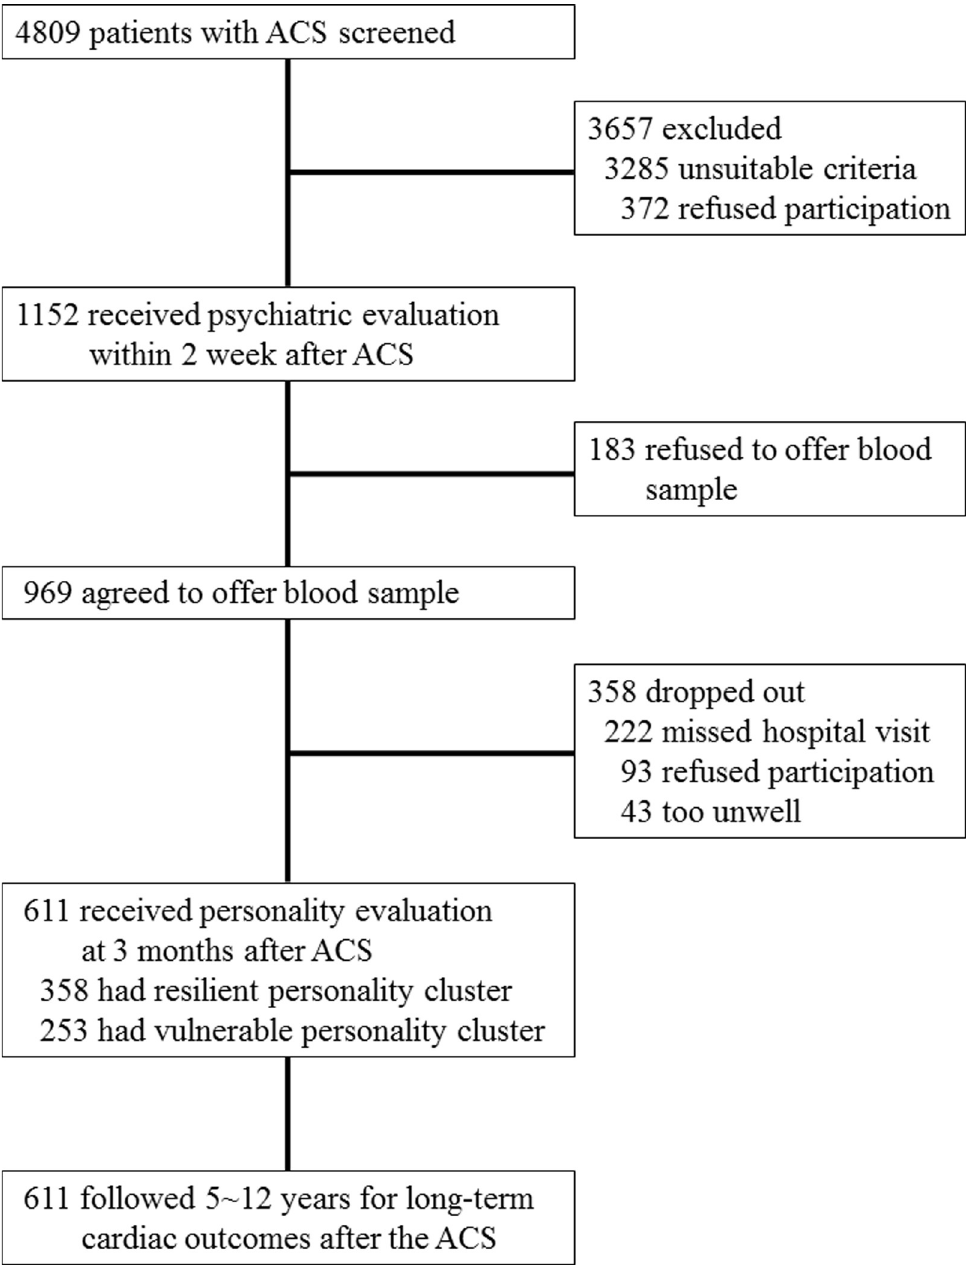
Fig 1. Flow chart. ACS: acute coronary syndrome, Baseline 969 participants, agreed to offer blood sample, received all psychiatric evaluations other than personality within 2 weeks after the index ACS episodes. Of them, 611 received personality evaluation at 3 months, and followed 5~12 years for cardiac outcomes after the